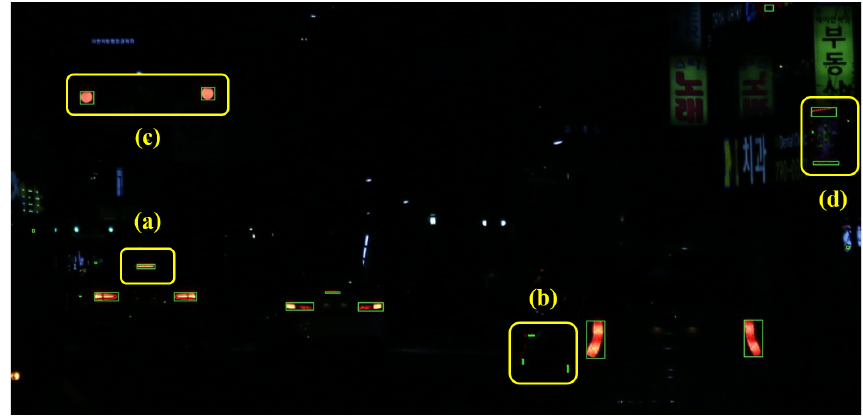
Figure 10. Outliers: ( a ) brake lamp; ( b ) noise; ( c ) traffic light; ( d ) advertisement